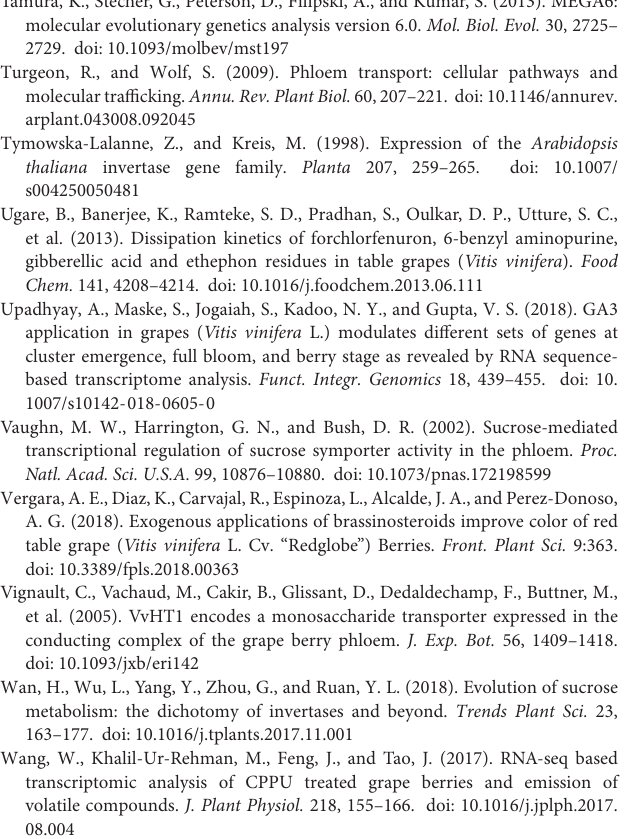
table grape ( Vitis vinifera L. Cv. “Redglobe”) Berries. Front. Plant Sci. 9:363. doi: